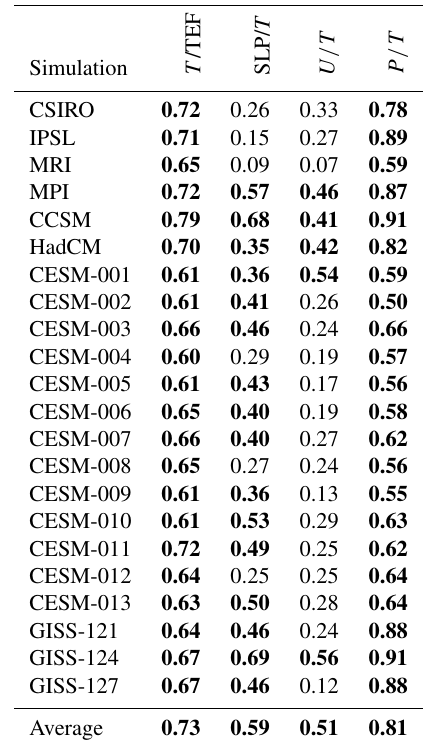
Table 2. Correlations between the first PC of surface temperature of each model simulation and TEF (Fig. 1a) and correlations for differ- ent simulations of the PC linked to the forcing for sea level pressure, zonal wind, and precipitation (first PC of SLP and zonal wind and second PC of precipitation) with the first PC of surface tempera- ture. Correlations of the average PC time series are also included. Significant correlations ( p < 0 . 05) accounting for autocorrelations are shown in